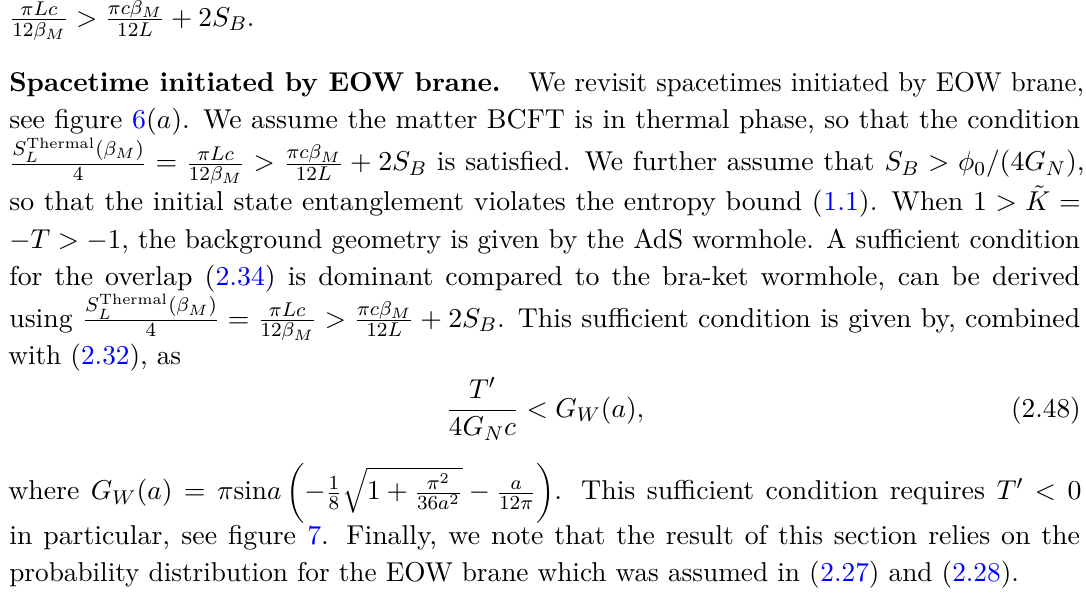
< G W ( a ) is sufficient (but not necessary) to 4 G N c